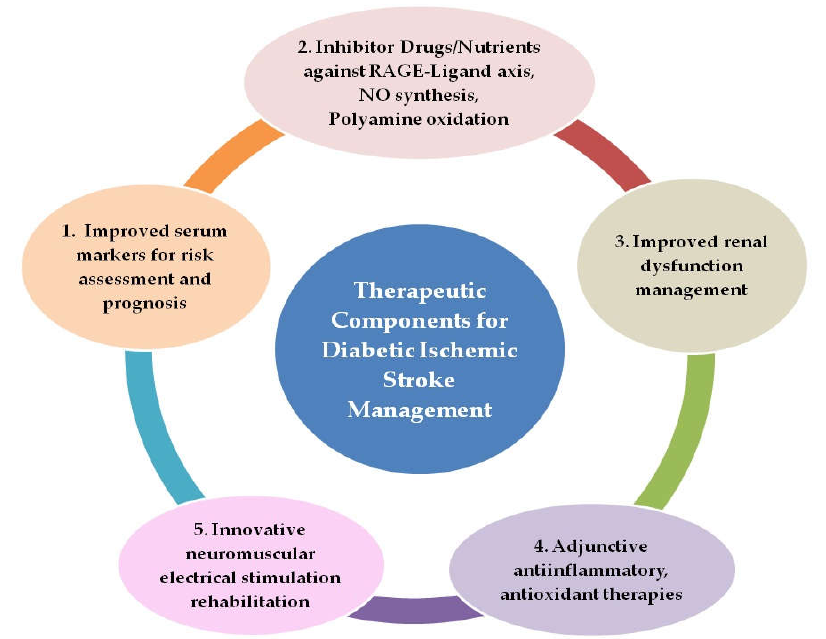
Figure 2. Components for comprehensive outcome-improvement therapeutic strategy in diabetic ischemic stroke patients.